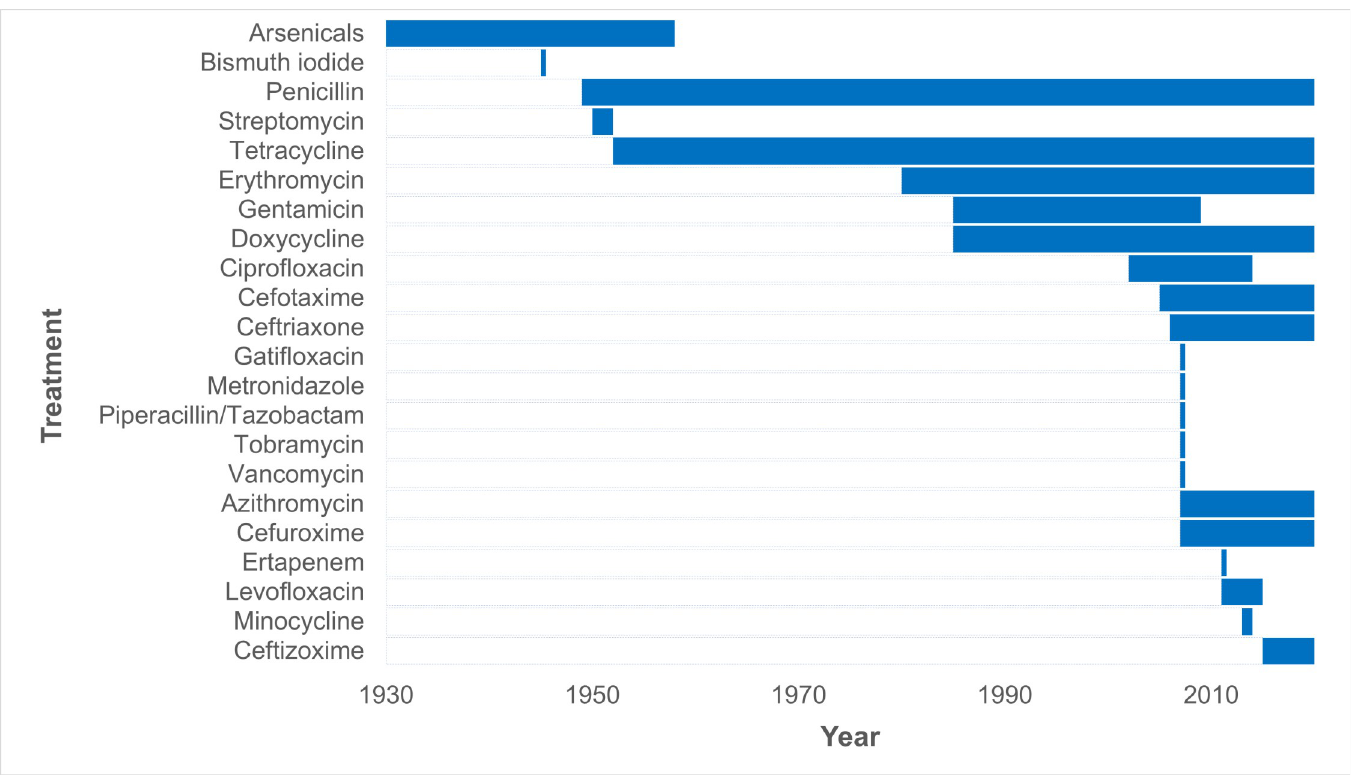
PCR, polymerase chain reaction.